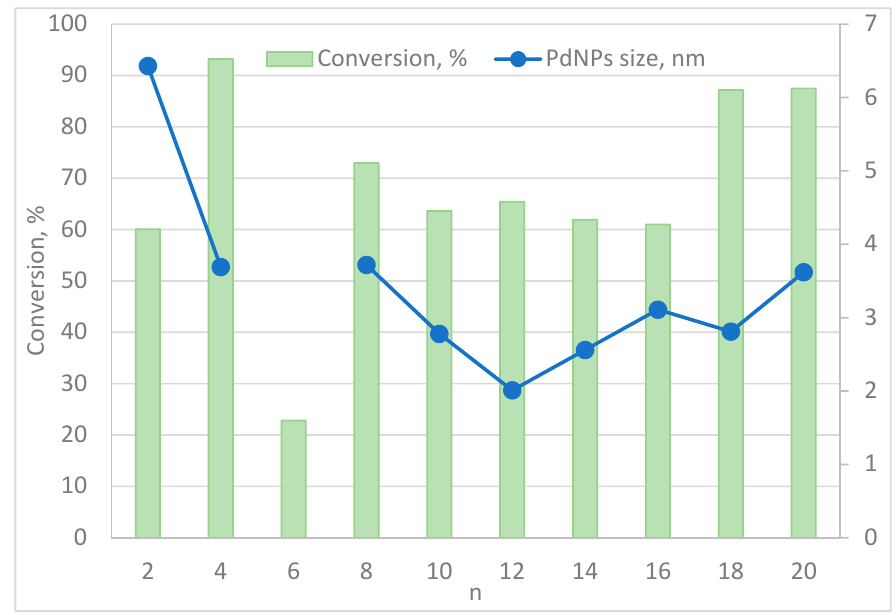
Figure 12. The PdNP size and the conversion of the Suzuki reaction depending on the phosphonium salt structure.